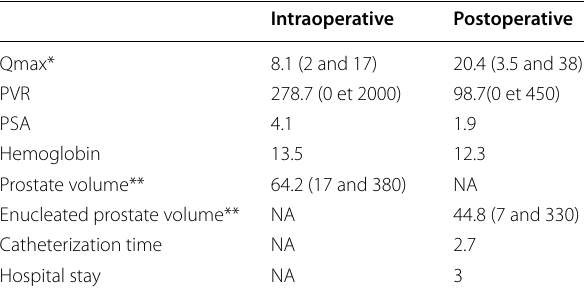
Table 2 Intra and postoperative